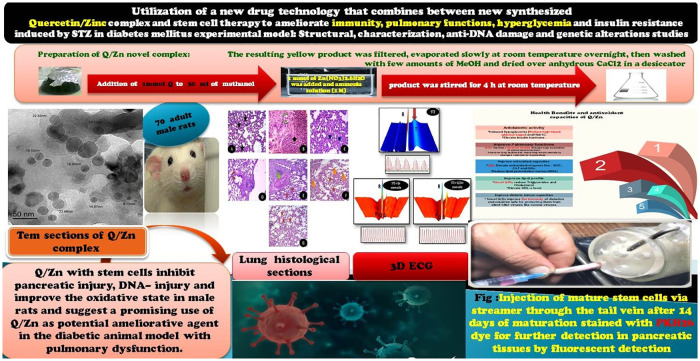
Graphical abstract.